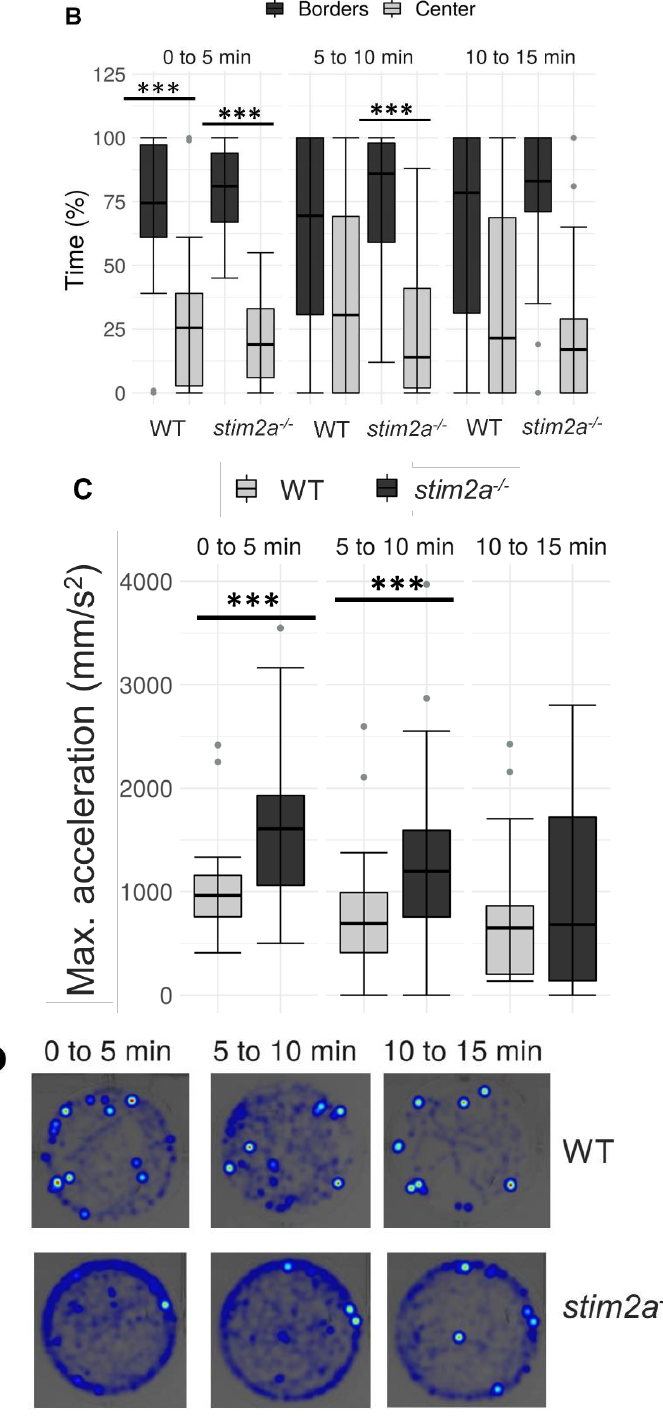
Figure 4. Higher thigmotaxis in stim2a − / − zebrafish in the open field test adopted for zebrafish larvae. Activity of the larvae was recorded for 15 min in a 12-well plate. The experiment was divided into three phases, 5 min each (0–5 min, 5–10 min, and 10–15 min). Fish that did not move were not included in the analysis. ( A ) Box plots show the distance traveled (in millimeters) in WT and stim2a − / − fish at either the edge of the well or in the center. ( B ) Box plots of the time spent moving (duration of movement) while swimming either at the edge of the well or in the center. ( C ) Box plots show the maximum acceleration (in millimeters per squared second) of WT and stim2a − / − fish in total throughout the well. ( D ) Heat maps show the total distance covered by the larvae in each phase of the experiment. * p < 0.05, *** p < 0.001 (paired Wilcoxon rank-sum test for comparisons between the edge and center; unpaired Wilcoxon rank-sum test for comparisons between WT and stim2a − / − mutants). n = 32 for WT larvae. n = 33 stim2a − / − larvae. Number of experiments: